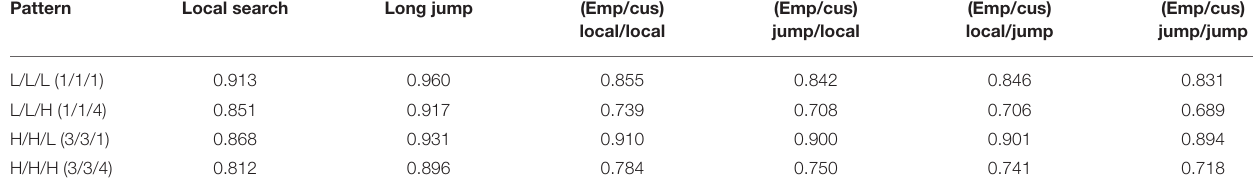
TABLE 1 | Results of computer simulation (service value after 500 steps). Pattern